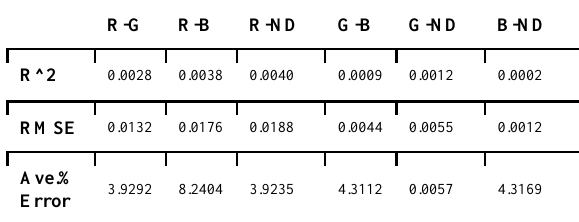
Table 4. Summary of statistical difference between each